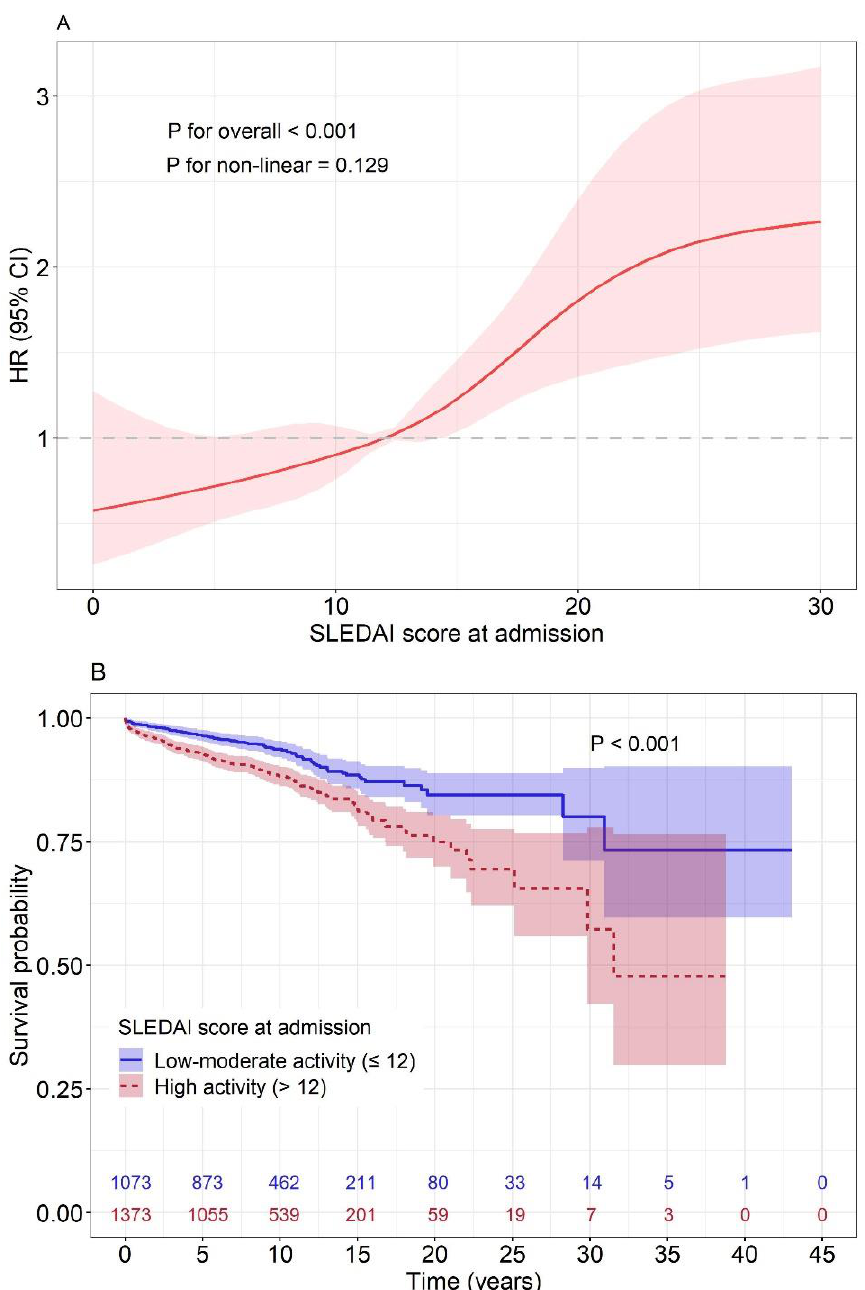
Figure 1. Association between SLE mortality and SLEDAI scores at admission of overall ( A ) and two groups of low–moderate activity and high activity ( B ). ( A ) The association between SLEDAI scores at admission and mortality in SLE using restricted cubic spline function with five knots, located at the 5th, 25th, 50th, 75th and 95th percentiles. The HRs and 95% CIs were calculated using the score of 12 as reference value and were adjusted for sex (male = 1, female = 0), age (continuous), comorbidities (yes = 1, no = 0), glucocorticoids treatment (yes = 1, no = 0) and immunosuppressive treatment (yes = 1, no = 0). ( B ) The comparison of survival probability was performed between low–moderate activity and high activity groups using SLEDAI at admission using Kaplan–Meier survival curves and log-rank tests.